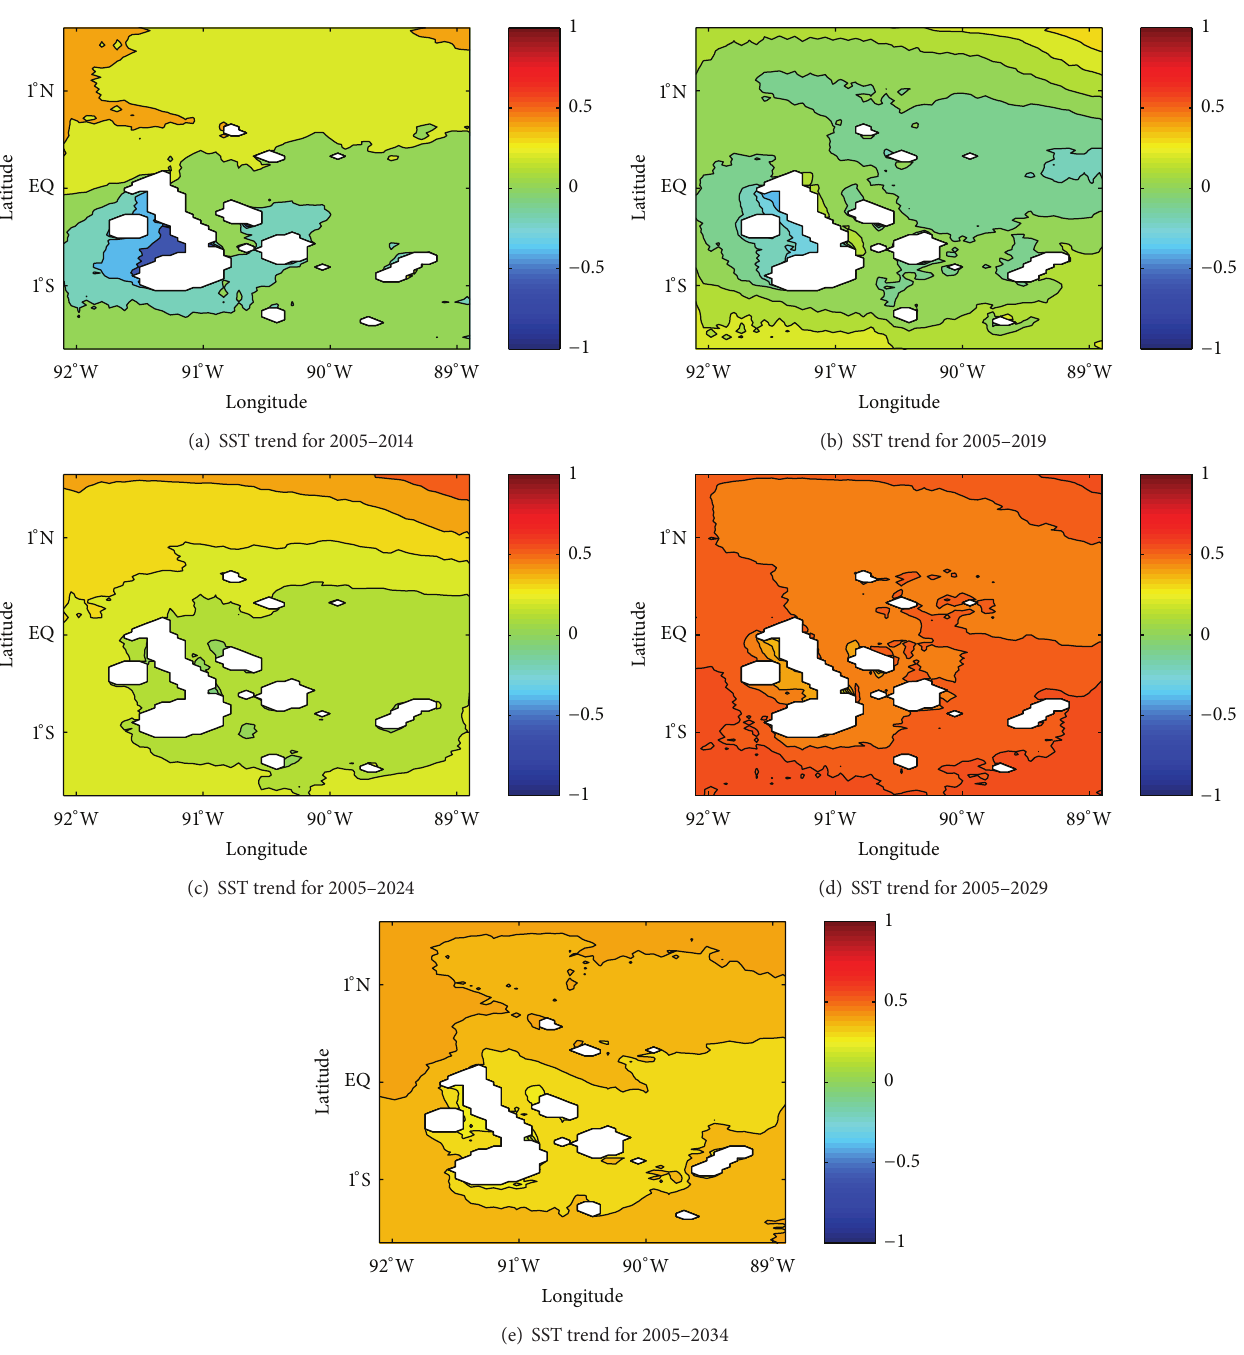
Figure 19: The SST trend contour around GMR for (a) 10yr from 2005–2014, (b) 15yr from 2005–2019, (c) 20 yr from 2005–2024, (d) 25yr from 2005–2029, and (e) 30yr from